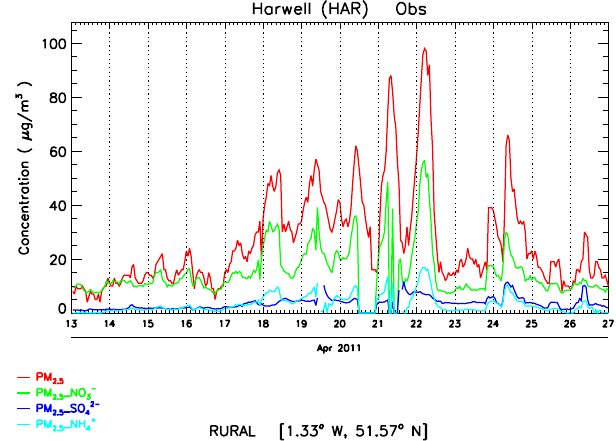
Fig. 10. Time series of hourly ozone concentrations (µgm − 3 ) for the rural site at Harwell, for April 2011. Observed concentrations are shown as the black dashed line and the model output as the solid orange line.